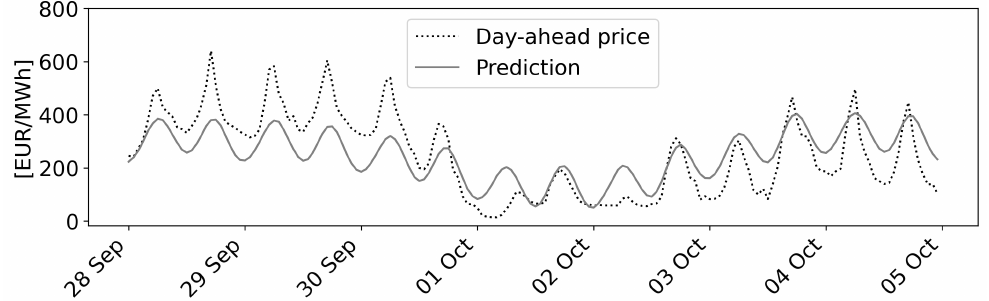
Figure 11. LSTM prediction for test scenario 2.